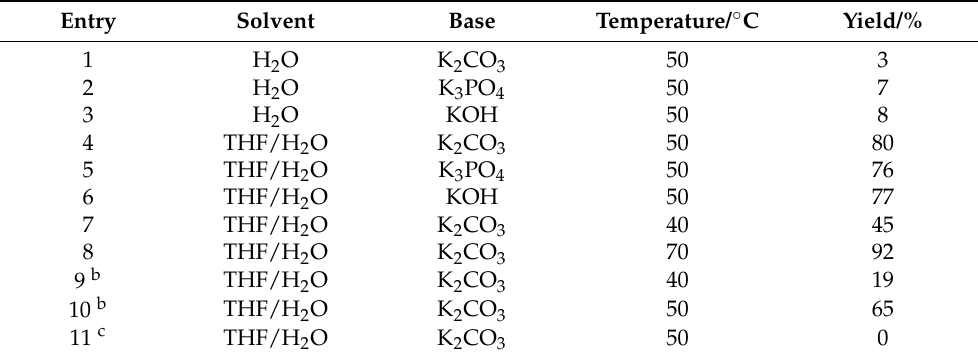
Table 1. Summary of the reaction conditions for the optimization of the Suzuki reaction a .